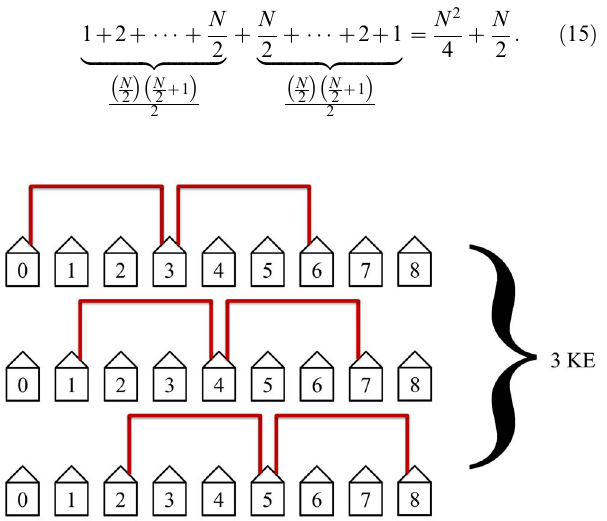
Figure 20. The seventh step in this example of a network of size N ~ 8 . This step is not efficient but only requires two KEs since there are only two such pairs of host.